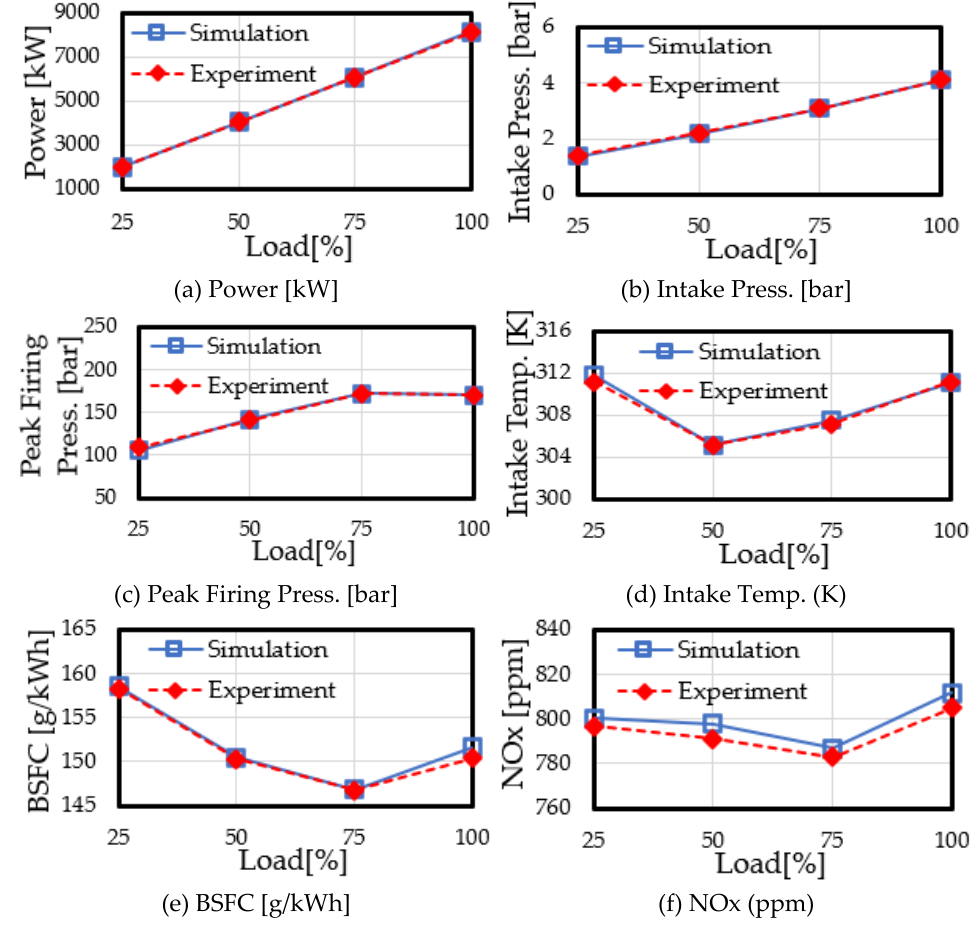
Figure 4. Validation results of primary parameter of the gas mode. Table 5. Calculation error of the gas mode.